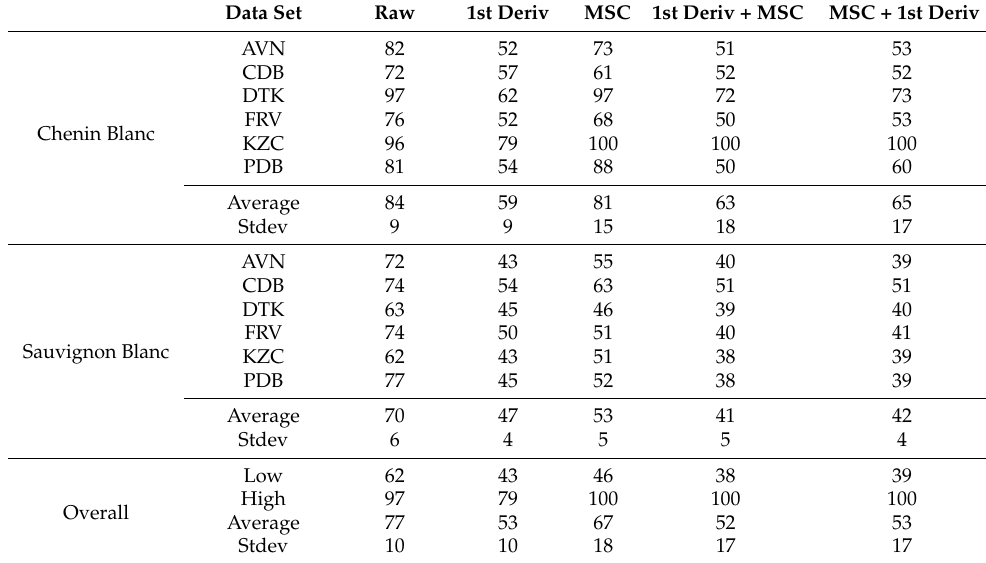
Table 2. Cumulative percentage explained variance for the first two principal components of the infrared raw data and its mathematical